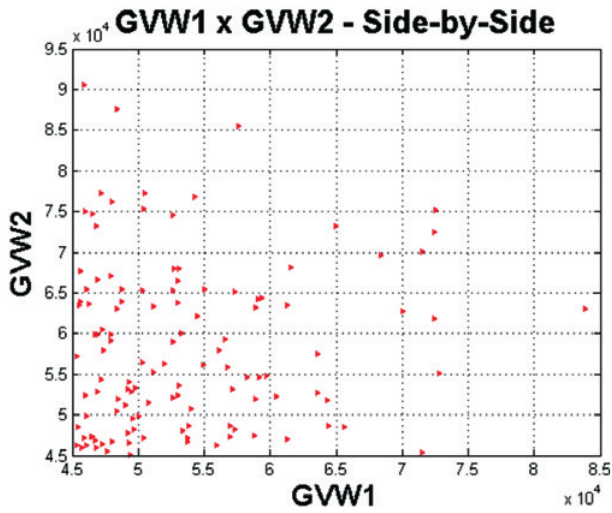
Relation of GVW 1 and GVW 2 in kg for side-by-side event- only heavy